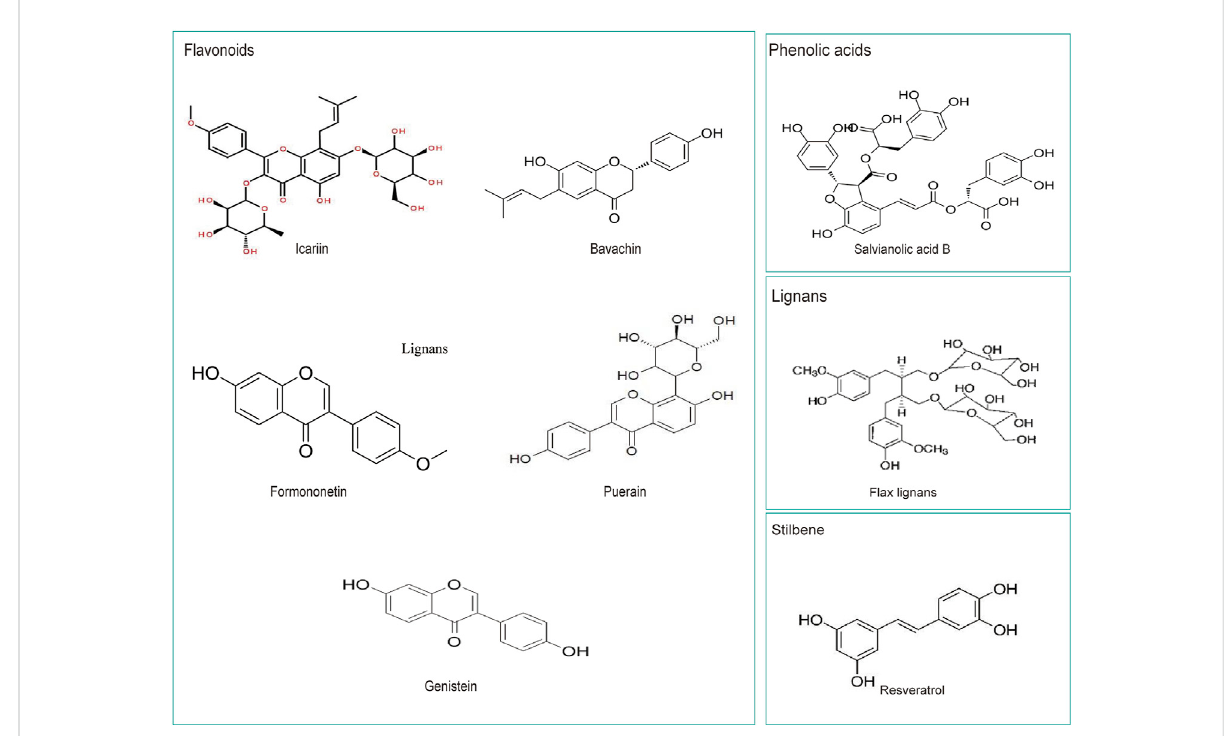
The chemical structures of several widely studied polyphenols in Chinese herbal medicine.